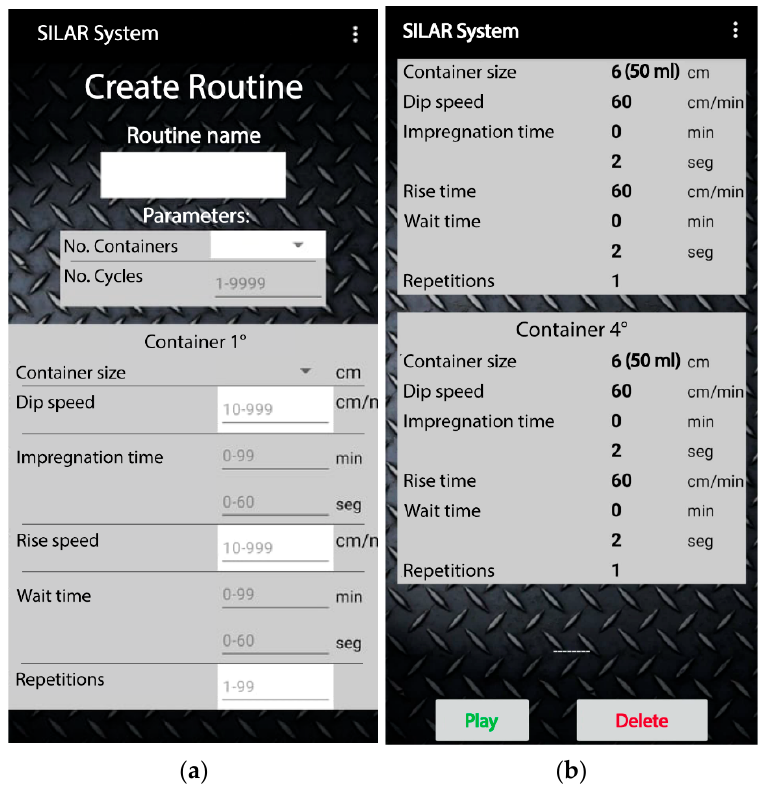
Figure 9. Graphical user interface of the mobile app: ( a ) input parameters to create a routine and ( b ) registered parameters of a sample routine. ( b ) registered parameters of a sample